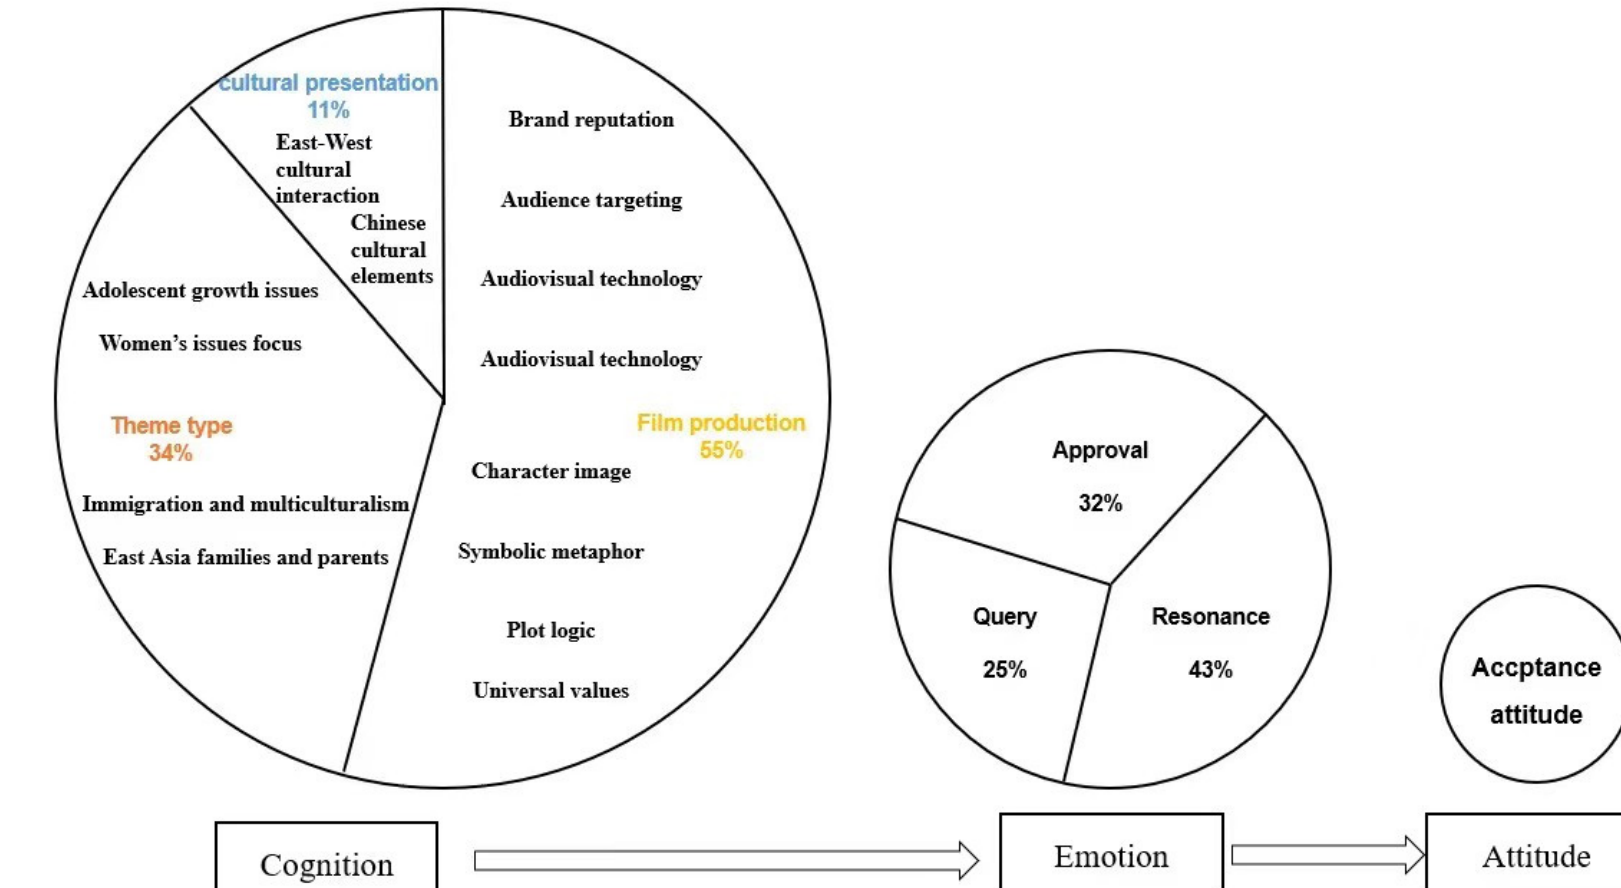
Figure 1. The mechanistic model of the audience-acceptance attitude formation process.